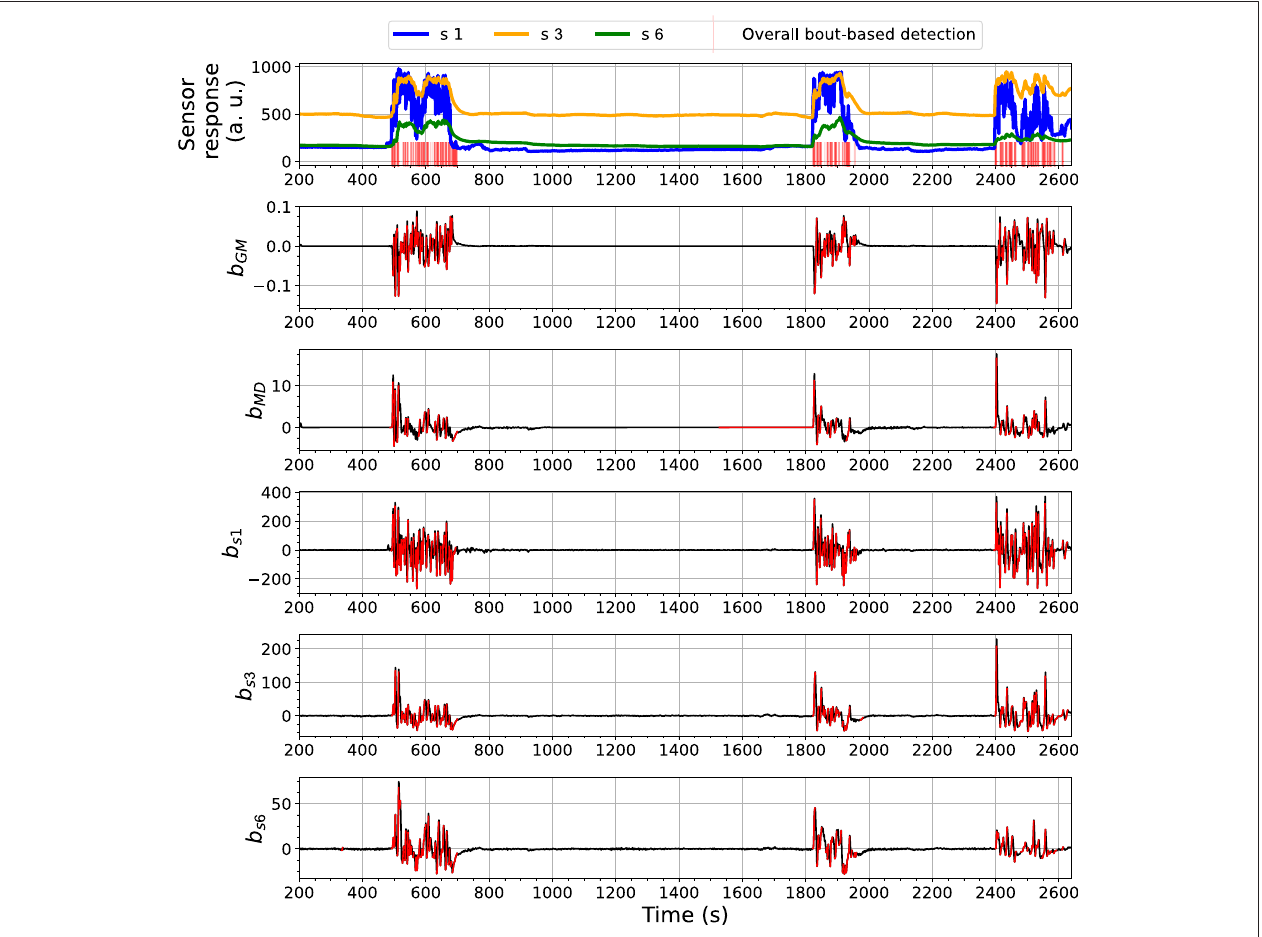
FIGURE8| BoutanalysisandthepredictionresultoftheBout-CountDetection(BCD)modelusingORUnoseontheExp.3-sourcetrial.Theoverallboutdetection madebytheBCDmodelisvisualizedinthetopsub fi gure,wheretimestepswithinthedurationofafoundboutaremarkedwithredverticallines.Thedetectedand fi ltered bouts in each signal are highlighted in red in the rest sub fi gures.